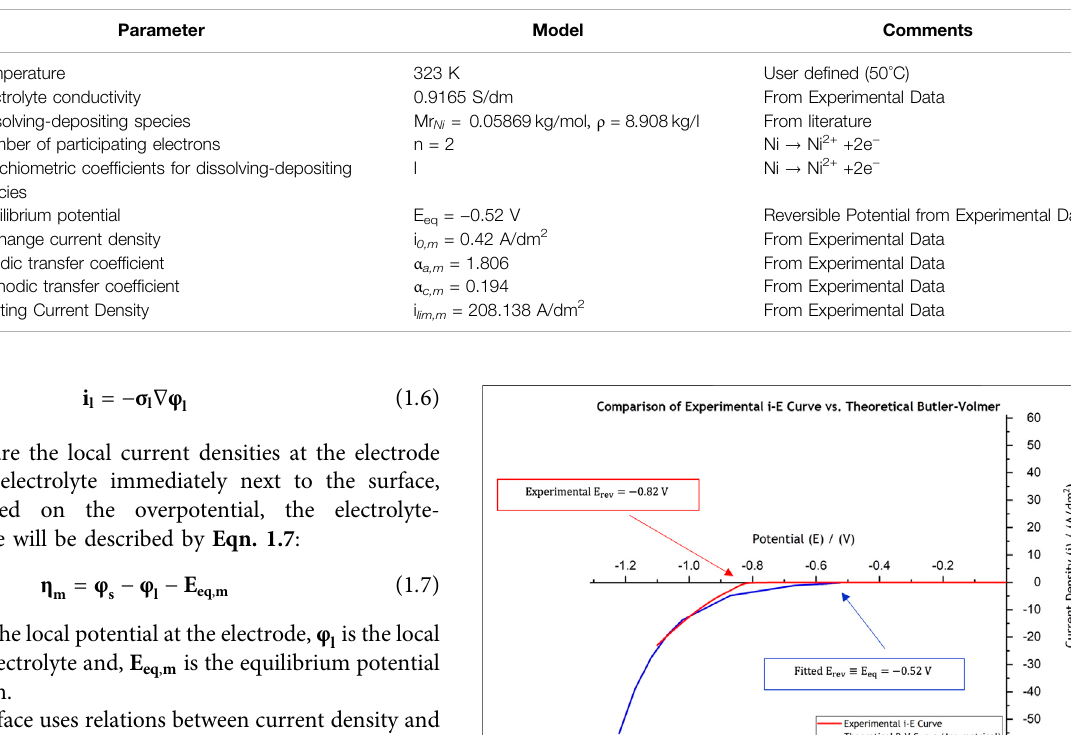
TABLE 1 | Physical and (electro)chemical model input parameters.